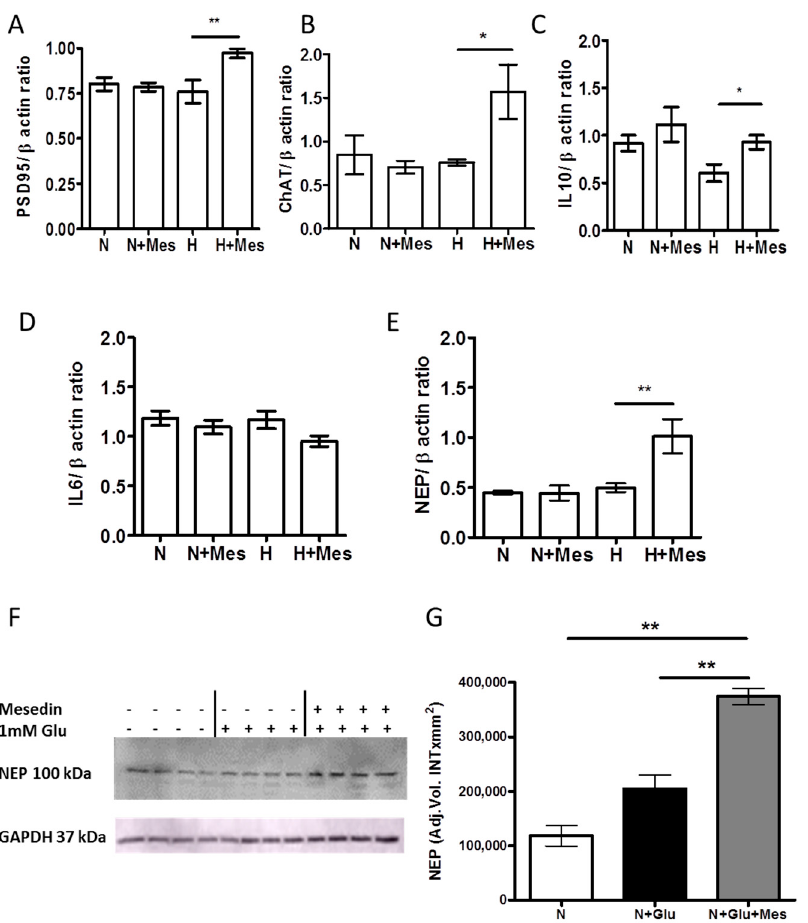
Figure 5. The impact of mesedin on the cholinergic, synaptic, and inflammatory markers in wild type APC and A β degrading function of 3×Tg-AD APC. ( A – E ) qPCR analyses of postsynaptic density protein 95, PSD95( A ), choline acetyltransferase, ChAT ( B ), Interleukine-10 ( C ), Interleukine-6, IL-6 ( D ), and neprilysin, NEP ( E ) upon normoxia (N), hypoxia (H) with 10 µM mesedin (N + Mes; H + Mes) vs. respective controls (N; H). ( F ) Representative Western blot and ( G ) densitometric analysis of NEP in APC from two-month-old 3 × Tg-AD mice upon normoxia (N) with and without glutamate (Glu), and 10 µ M mesedin ( n = 4). Glycerinaldehyd-3-phosphat-Dehydrogenase (GAPDH) served as loading control. Data are presented as mean ± SEM and analyzed by one-way ANOVA with Bonferroni’s comparison test. * p < 0.05; ** p < 0.01.